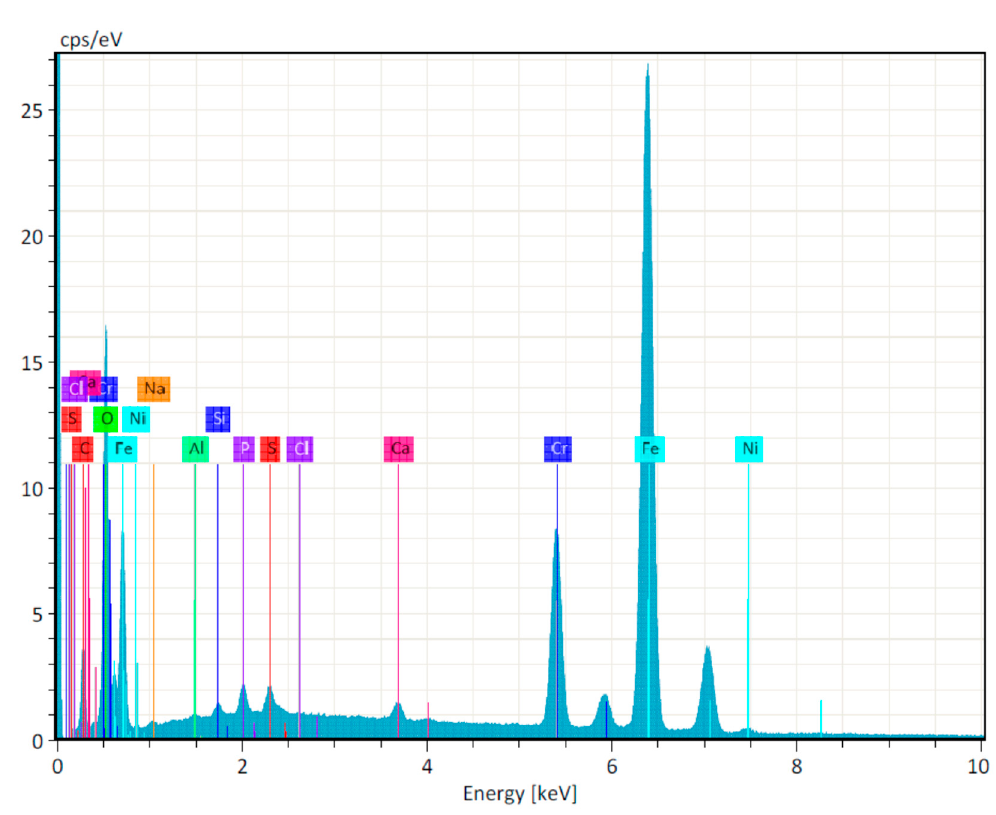
Figure 3. Group 1. The spectroscopic analysis of the drill surface after 50 disinfection cycles with glutaraldehyde showed a decrease in oxygen, iron, nickel, and chromium.